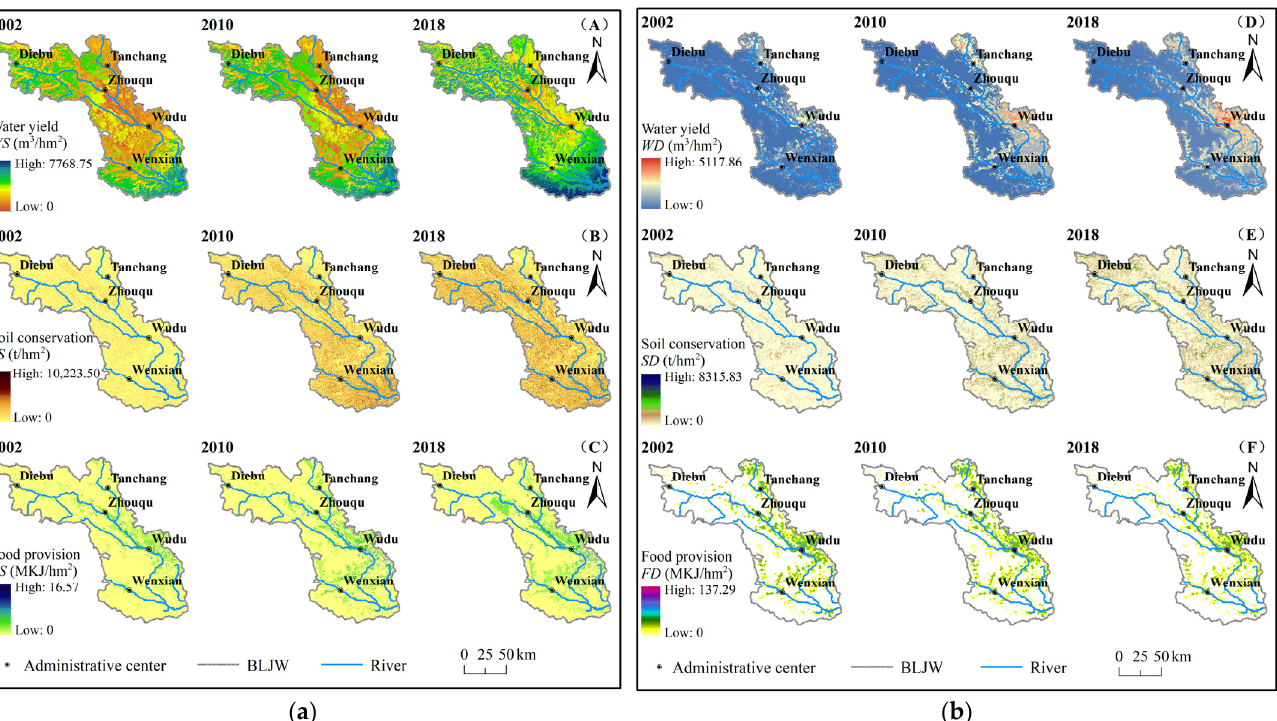
Figure 3. Spatial distributions of the ESs supply ( a ) and demand ( b ) in the BLJW from 2002 to 2018. Note: series ( A ) shows the water supply from 2002 to 2018, series ( B ) shows the soil-conservation supply from 2002 to 2018, series ( C ) shows the food supply from 2002 to 2018, series ( D ) shows the water demand from 2002 to 2018, series ( E ) shows the soil-conservation demand from 2002 to 2018, series ( F ) shows the food demand from 2002 to 2018. Table 1. ESs supply and demand in the BLJW from 2002 to 2018.